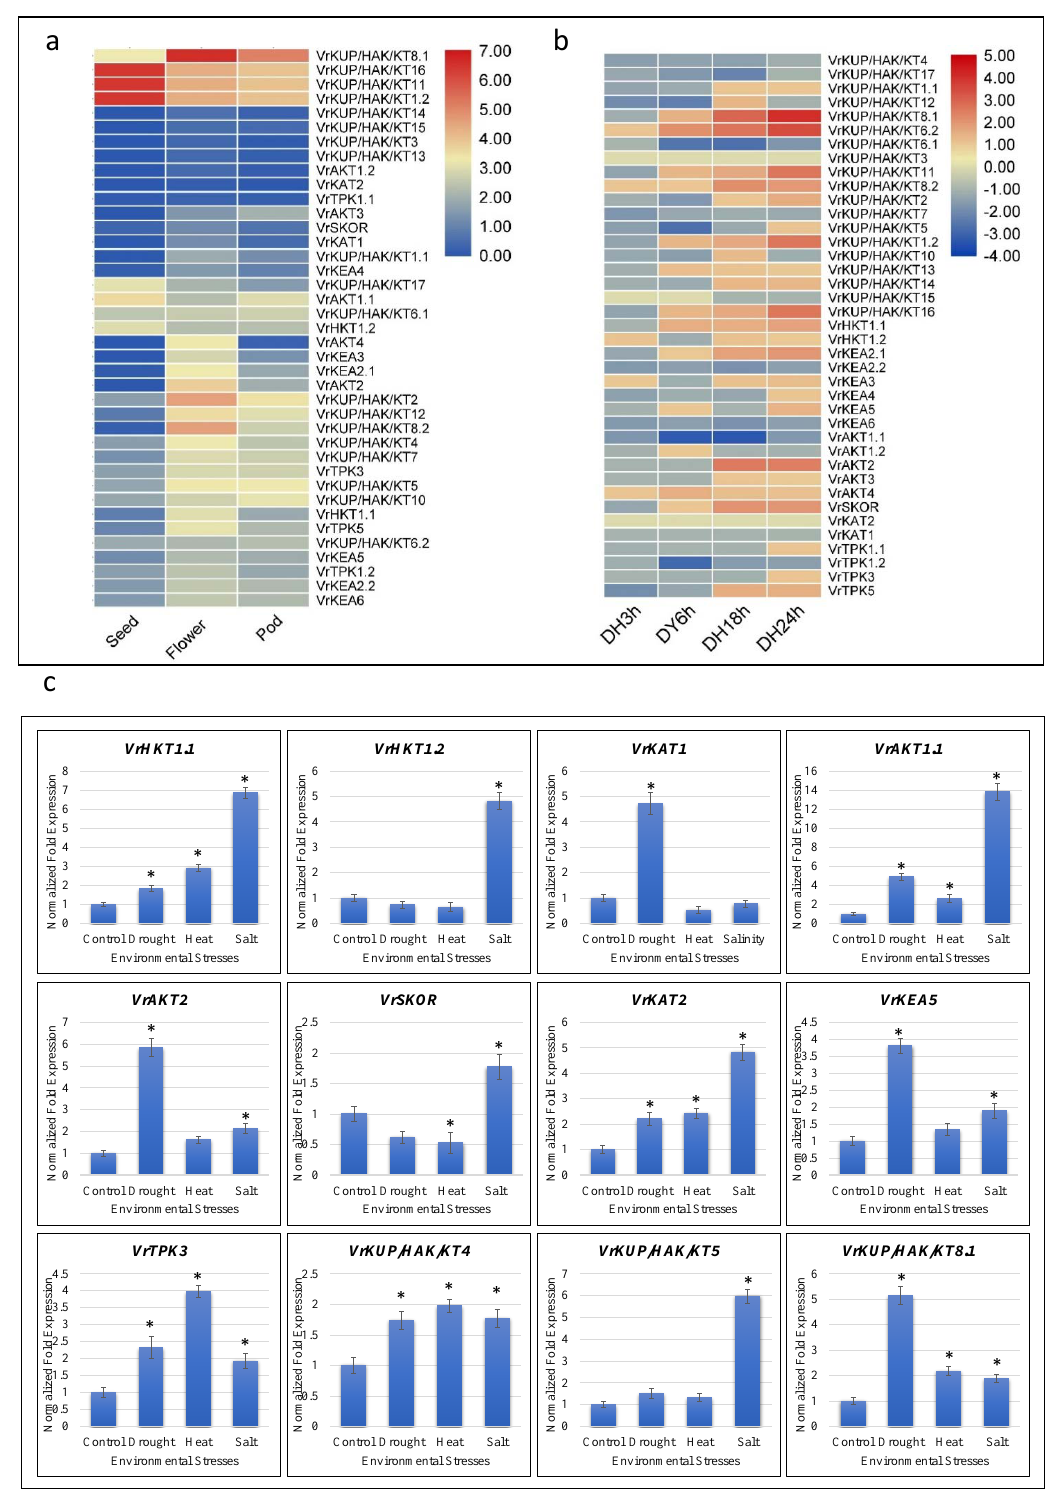
Figure 5. ( a ) Representation of the tissue-specific expression of potassium transport genes in normal conditions. Tissue samples were collected from seeds, pods, and flowers. ( b ) Representation for the expression of potassium transport genes in control and dehydration stress conditions (the blue color represents an absence of a gene, while the red color represents the expression level for highly expressed genes). ( c ) Relative qRT-PCR assay of selected potassium-related genes under heat, drought, salt, and heat stresses. The default expression value for each gene was 1 in non-treated plants. (* p <